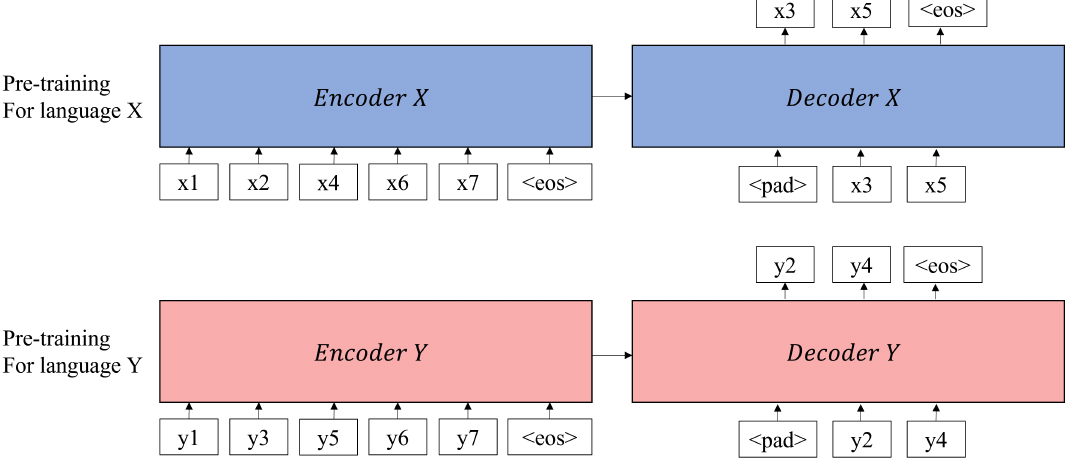
Figure 1. Monolingual pre-training of each model. The model is trained to generate the dropped